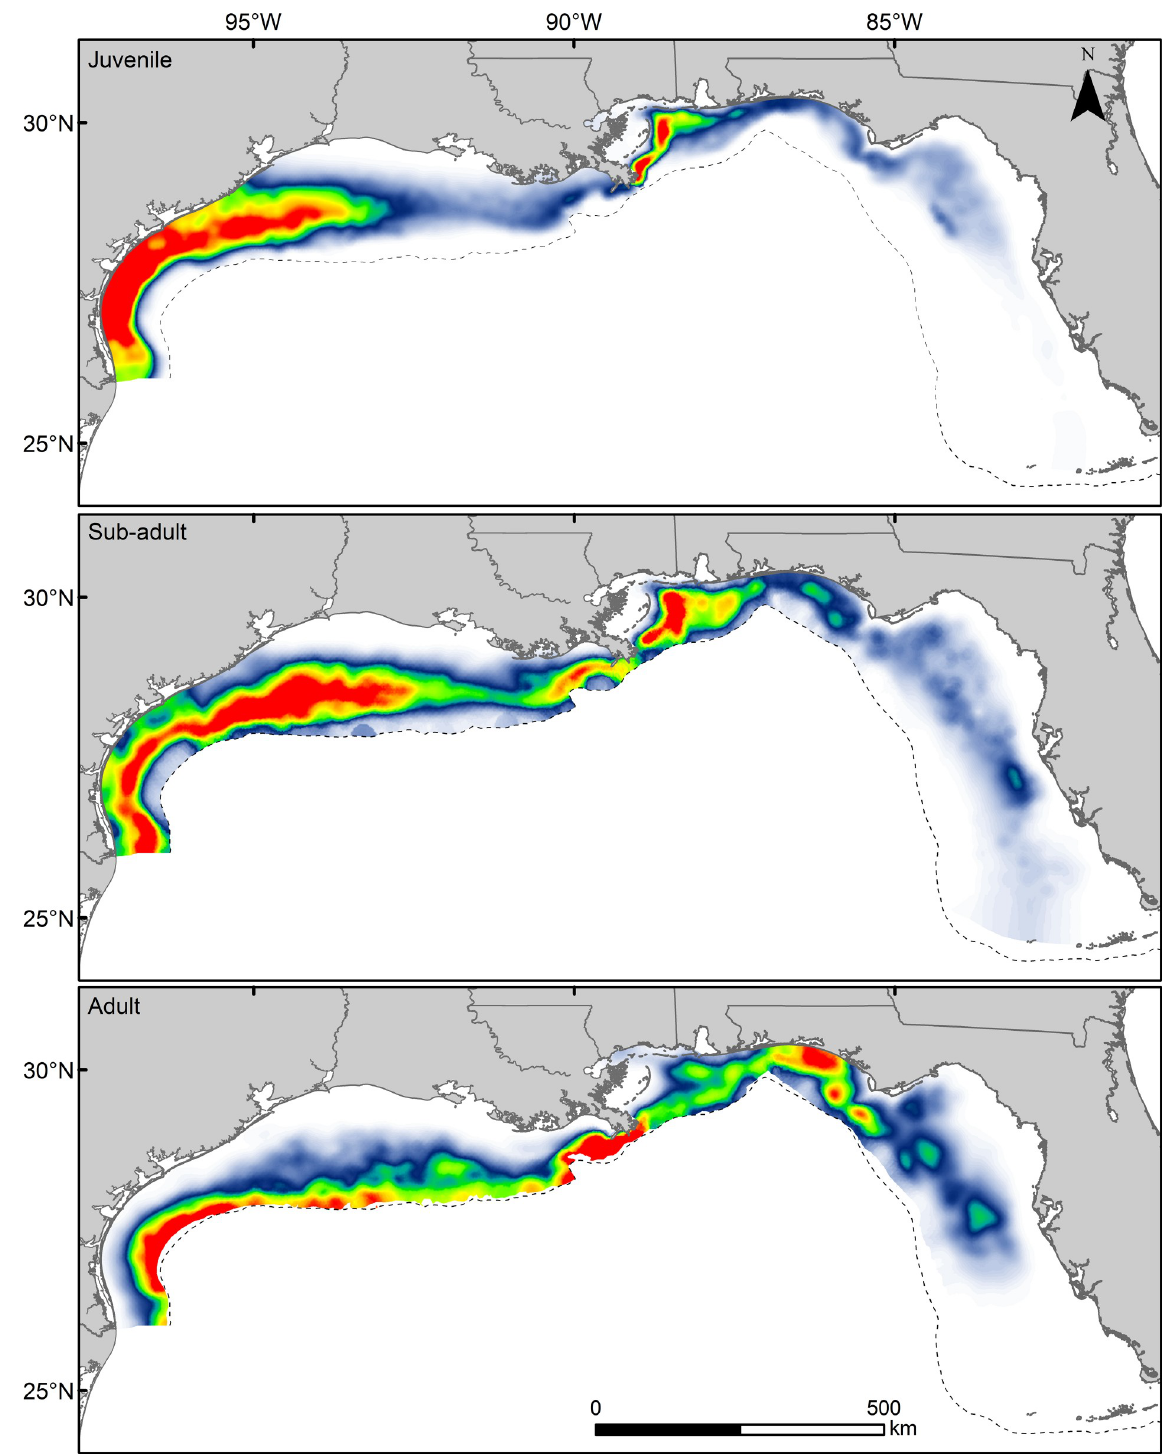
Fig 6. Predicted relative abundance of red snapper in shelf waters ( < 150 m) of the U.S. GoM. Spatial distributions of predicted relative abundance of juvenile (age-0), sub-adult (age-1-2), and adult (age-2+) red snapper over unconsolidated substrates of the U.S. GoM based on final generalized additive models for each life stage and mean environmental conditions during the fall season (September-October). Relative abundance reflects predicted catch per trawl tow, and the scale for each panel differs: juvenile (0–56), sub-adult (0–13), and adult (0–3). Dashed line represents 150-m